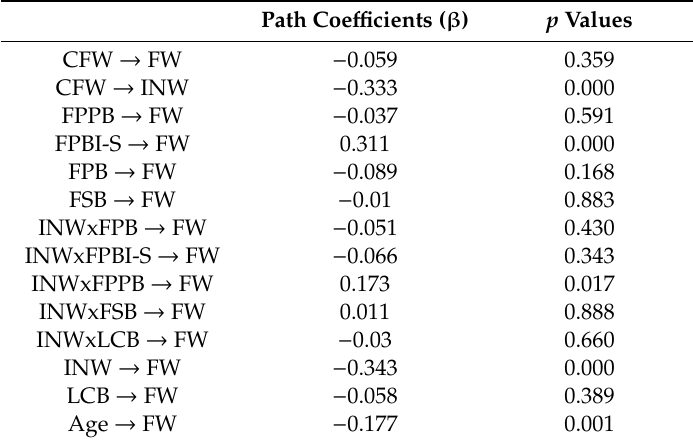
Table 8. Path coe ffi cients ( β ) and significances ( p ).